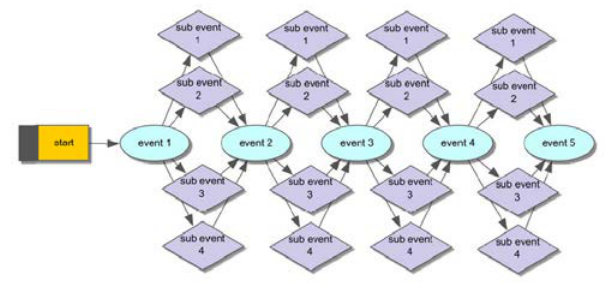
Figure 1. Multiple route structure